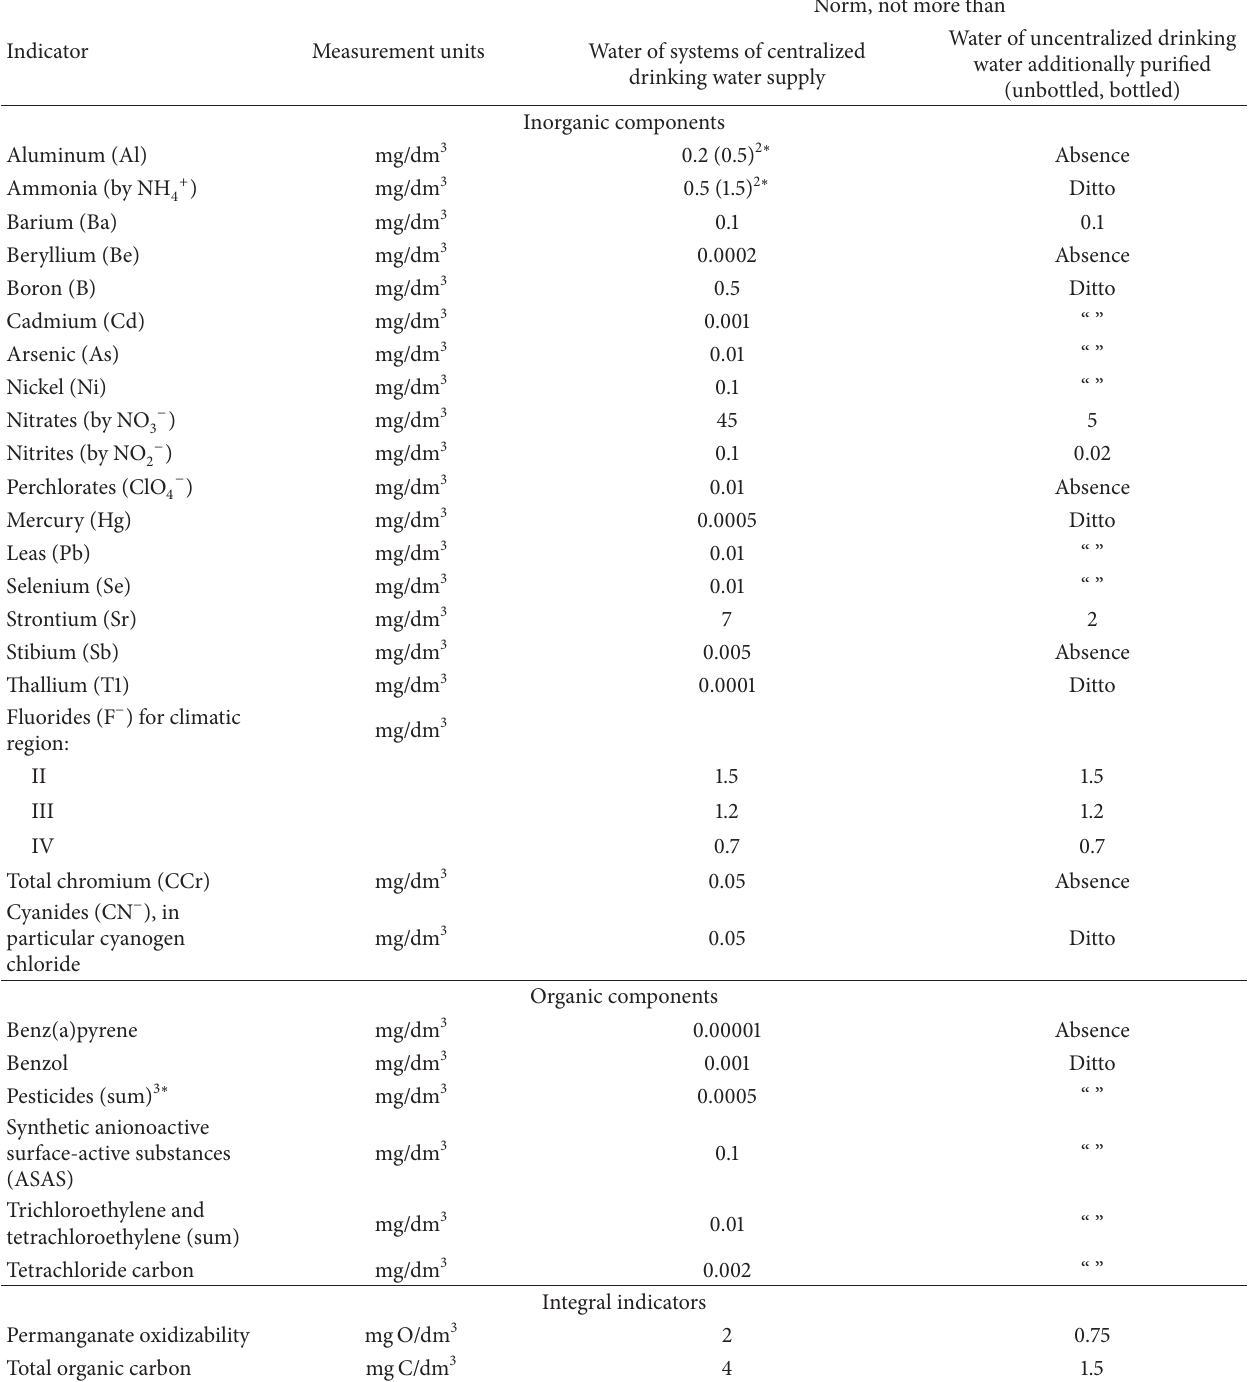
Table 6: Toxicological indicators of the harmlessness of drinking water chemical composition 1∗